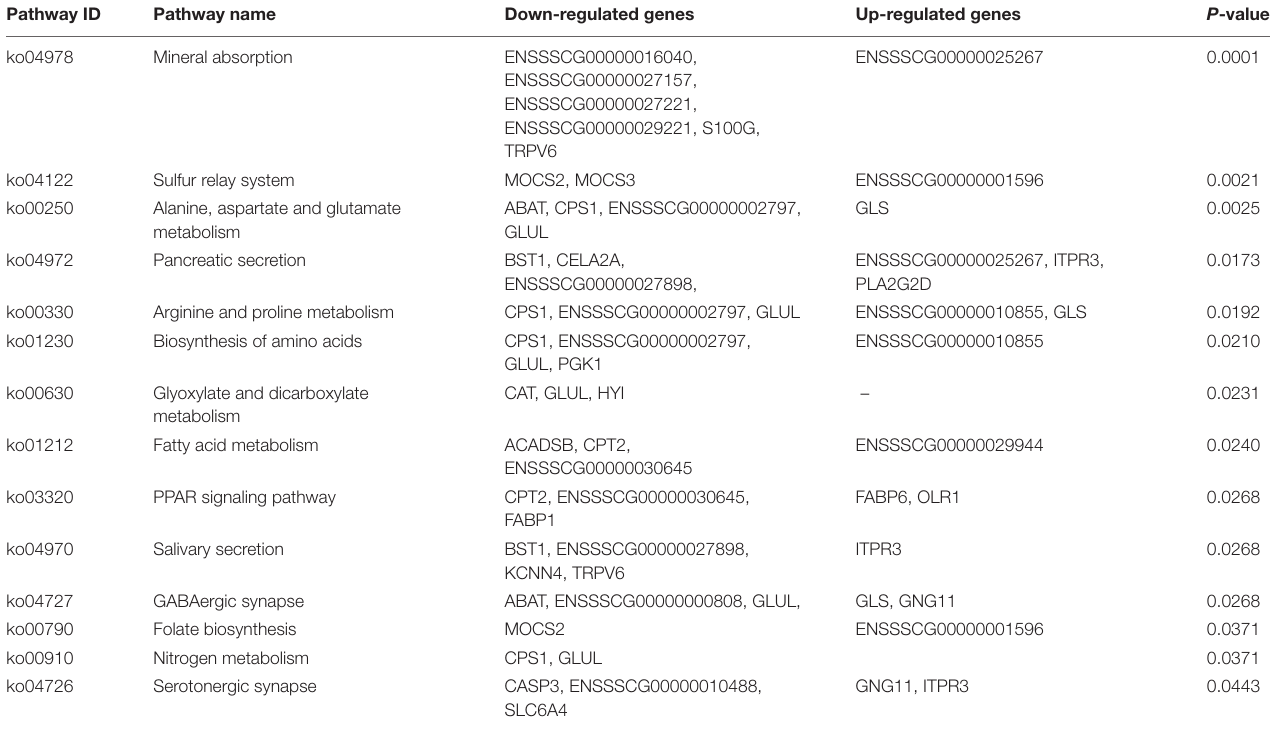
TABLE 1 | KEGG pathway enrichment of